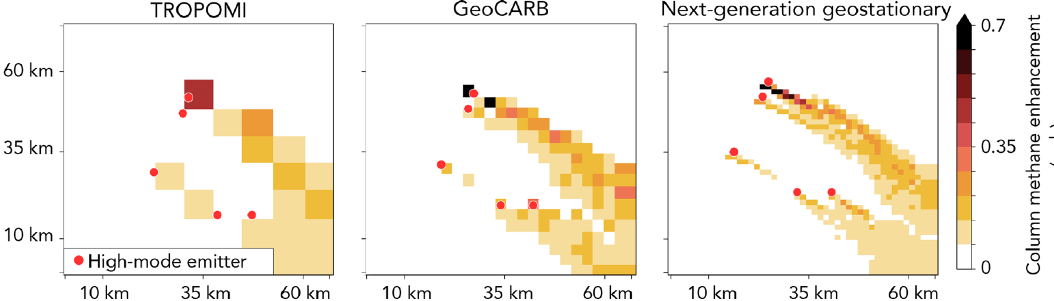
Figure 4. Simulated noiseless methane column enhancement for sampling by single overpasses of TROPOMI, GeoCARB, and a next- generation high-resolution geostationary satellite (Table 1). Emission field is that of Fig. 2. The locations of the five high-mode emitters in that field are indicated. Values are for 22 October 2013 at